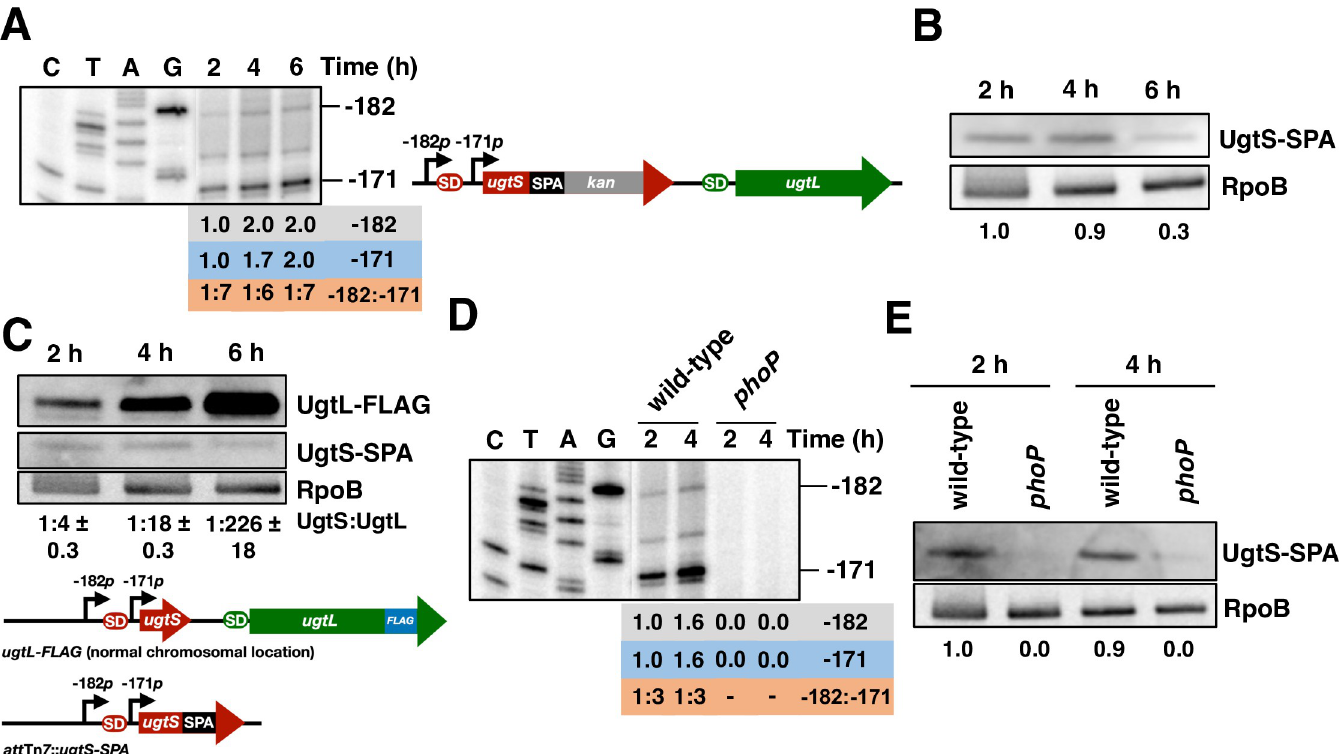
Fig 3. The ugtSugtL and ugtSugtL transcripts are PhoP-activated and exhibit distinct expression patterns in mildly acidic pH, resulting in differential -182 -171 abundance of the UgtS and UgtL proteins. (A) Primer extension analysis of the ugtSugtL -182 and ugtSugtL -171 transcripts in ugtS-SPA (HS1170) S . Typhimurium grown in N-minimal acidic pH medium (pH 4.9, 1 mM MgCl 2 ) for the indicated times. Primer extension was carried out on total RNA using primer W4055. The band observed at position -176 relative to the ugtL start codon corresponds to a W4055 primer-specific reverse transcription artefact. Transcript abundance relative to the leftmost lane is indicated for the -182 and -171 transcripts. -182:-171 transcript abundance ratios are indicated below the blot. The ugtS-SPA :: Km R construct is depicted in the right panel. The -182 p and -171 p (positions relative to ugtL ATG start codon) transcription start sites are indicated with arrows. SD, Shine-Dalgarno sequences (red and green for ugtS and ugtL , respectively). Data are representative of two independent experiments, which gave similar results. (B) Western blot analysis of crude extracts from ugtS-SPA (HS1170) S . Typhimurium grown in N-minimal acidic pH medium (pH 4.9, 1 mM MgCl 2 ) for the indicated times. Samples were analyzed with antibodies directed to the FLAG epitope or the RpoB protein. Protein abundance relative to the leftmost lane is indicated below the blot. Data are representative of two independent experiments, which gave similar results. (C) Western blot analysis of crude extracts from att Tn 7 :: ugtS-SPA ugtL-FLAG (HS1940) S . Typhimurium grown in N-minimal acidic pH medium (pH 4.9, 1 mM MgCl 2 ) for the indicated time points. Samples were analyzed with antibodies directed to the FLAG epitope or the RpoB protein. UgtL/UgtS protein amounts ratios are marked below. Data are representative of two independent experiments, which gave similar results. The att Tn 7 :: ugtS-SPA ugtL-FLAG construct is depicted in the lower panel. The -182 p and -171 p (positions relative to ugtL ATG start codon) transcription start sites are indicated with arrows. SD, Shine-Dalgarno sequences (red color for ugtS Shine-Dalgarno sequence, green color for ugtL Shine-Dalgarno sequence). (D) Primer extension analysis of ugtSugtL - and ugtSugtL transcripts levels in ugtS-SPA (HS1170) and ugtS-SPA phoP (HS1178) S . Typhimurium grown in N-minimal acidic pH medium (pH 4.9, 1 mM 182 -171 MgCl 2 ) for the indicated time points. Primer extension reaction was carried out on total RNA samples using primer W4055. The band observed at position -176 relative to the ugtL start codon corresponds to a W4055 primer-specific reverse transcription artefact. Transcript abundance relative to the leftmost lane is indicated for the -182 and -171 transcripts. -182:-171 transcript abundance ratios are marked below. Data are representative of two independent experiments, which gave similar results. (E) Western blot analysis of crude extracts from att Tn 7 :: ugtS-SPA (HS1795) and att Tn 7 :: ugtS-SPA phoP (HS1823) S . Typhimurium grown in N-minimal acidic pH medium (pH 4.9, 1 mM MgCl 2 ) for the indicated time points. Samples were analyzed with antibodies directed to the FLAG epitope or RpoB protein. Protein abundance relative to the leftmost lane is marked below. Data are representative of two independent experiments, which gave similar